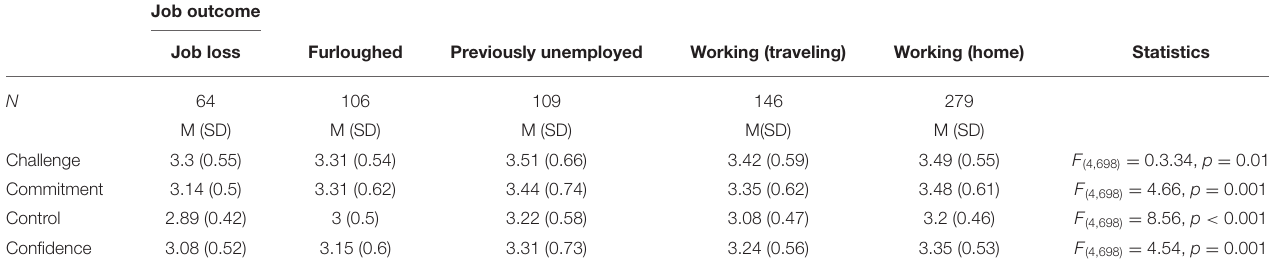
TABLE 6 | MT scores for job outcome group.